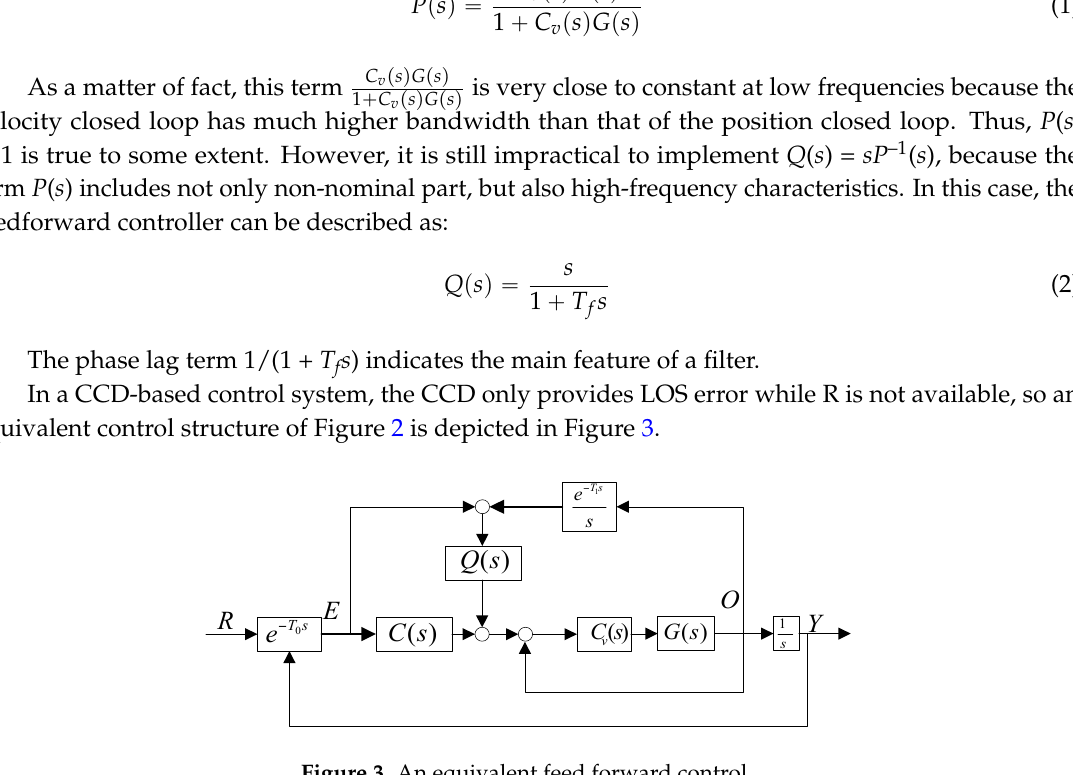
Figure 3. An equivalent feed forward control.